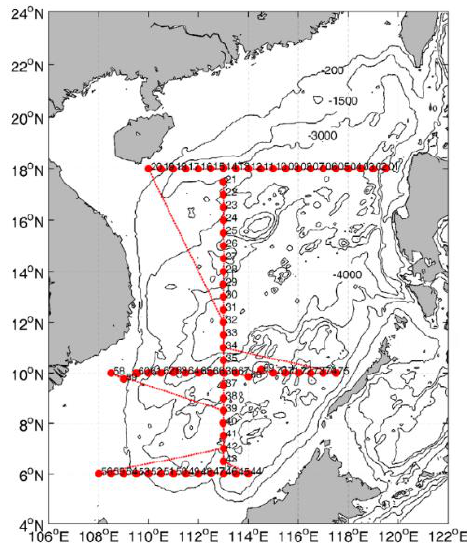
Figure 1. Sites of the dataset in the South China Sea. Each dataset contains 11 types of information, which are listed in Table